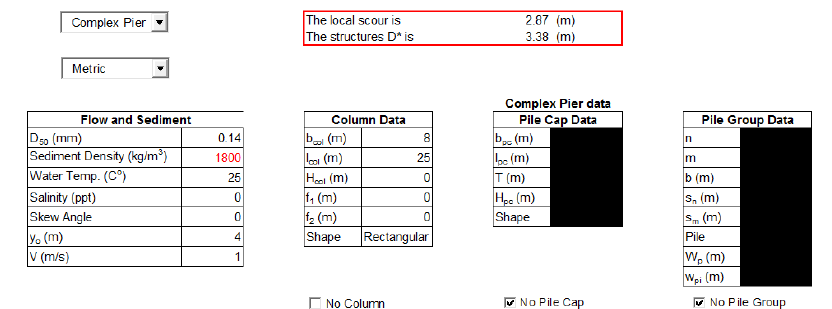
Figure 16. Scour depth calculation using FDOT